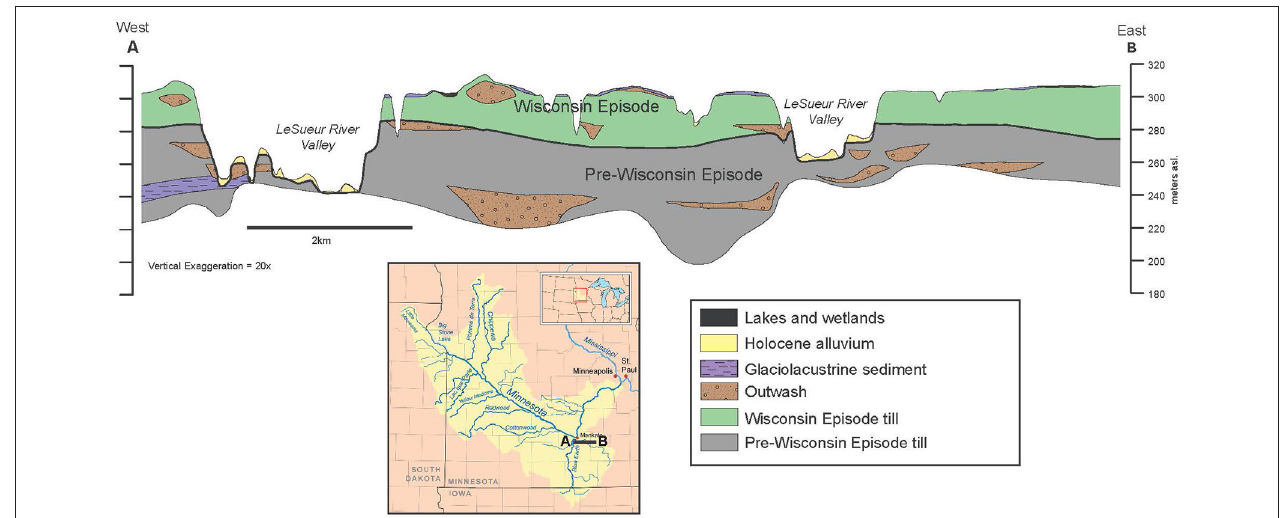
FIGURE 6 | Simplified geologic cross-section through a typical portion of the Minnesota River basin, modified from the central/eastern portion of cross-section B–B ′ on plate 4 of the Digital Geologic Atlas of Blue Earth County ( Runkel et al., 2011). Used by permission of the Minnesota Geological Survey. Minnesota Pre-Wisconsin tills are likely pre-Illinois in age. The surficial geology features abundant glacial lake deposits with modern lake and wetland deposits also present. Knickpoint retreat up the LeSueur River has created multiple terrace surfaces, shown as Holocene Alluvium. Isolated bodies of sorted sand and gravel are present in the subsurface within both Wisconsin Episode and pre-Wisconsin Episode